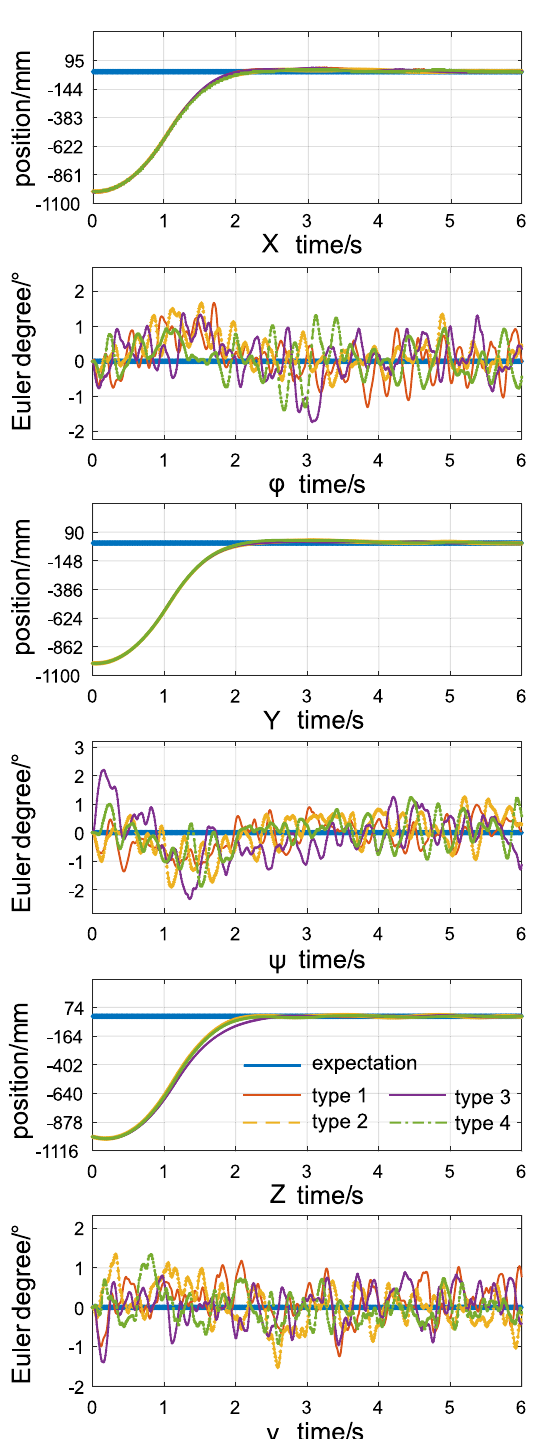
Figure 4. Errors associated with the control of 4 types of arm